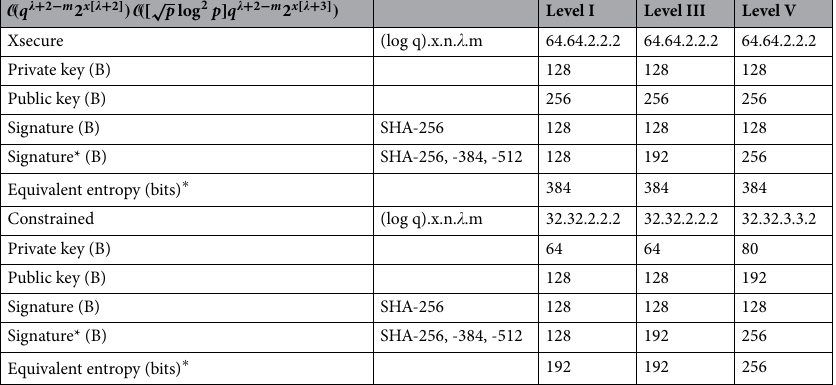
Table 3. We propose configuration of the Optimized MPPK/DS, and provide key and signature sizes as well as entropy based on the best discovered attack that correspond to the proposed parameter sets. ∗ Based on the best complexity among the two calculated. Public key sizes, private key sizes, and signature sizes of the Optimized MPPK/DS are characterized by the security parameters log p , log q , n , (cid:31) , m for NIST levels I, III, and V corresponding to all the discovered attacks.